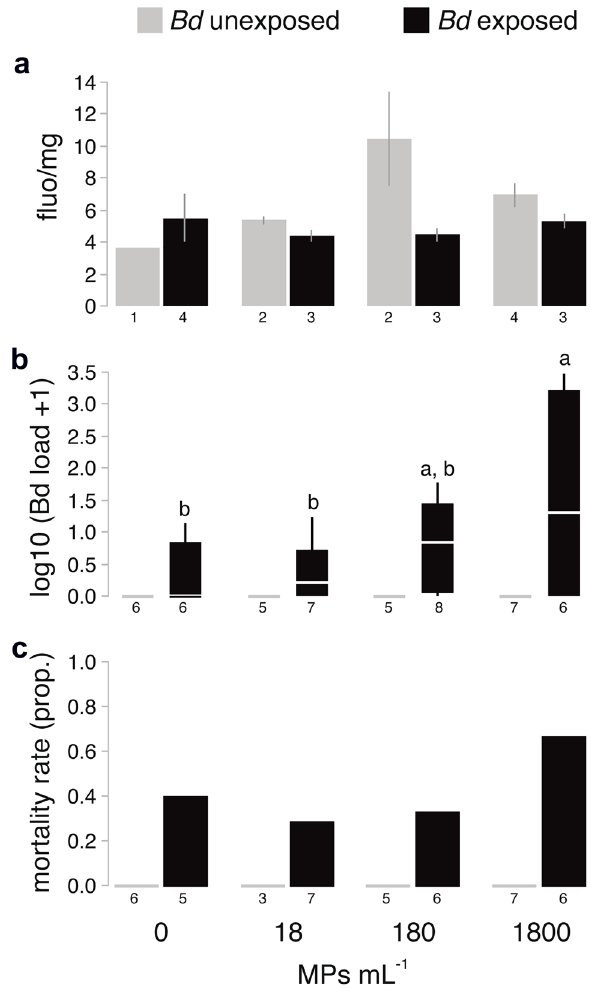
Figure 1. ( a ) Mean ± SE of fluorescence levels per tadpole mg, ( b ) log-transformed Bd loads (horizontal lines depict medians, boxes represent interquartile ranges and whiskers extend to minima-maxima), and ( c ) proportional tadpole mortality for each MP concentration (0, 18, 180 and 1800 MP mL −1 ) and Bd exposition treatment ( Bd unexposed and Bd exposed). Numbers below bars indicate the number of replicates for each group, and different letters indicate statistically significant differences after post hoc Tukey tests (p <